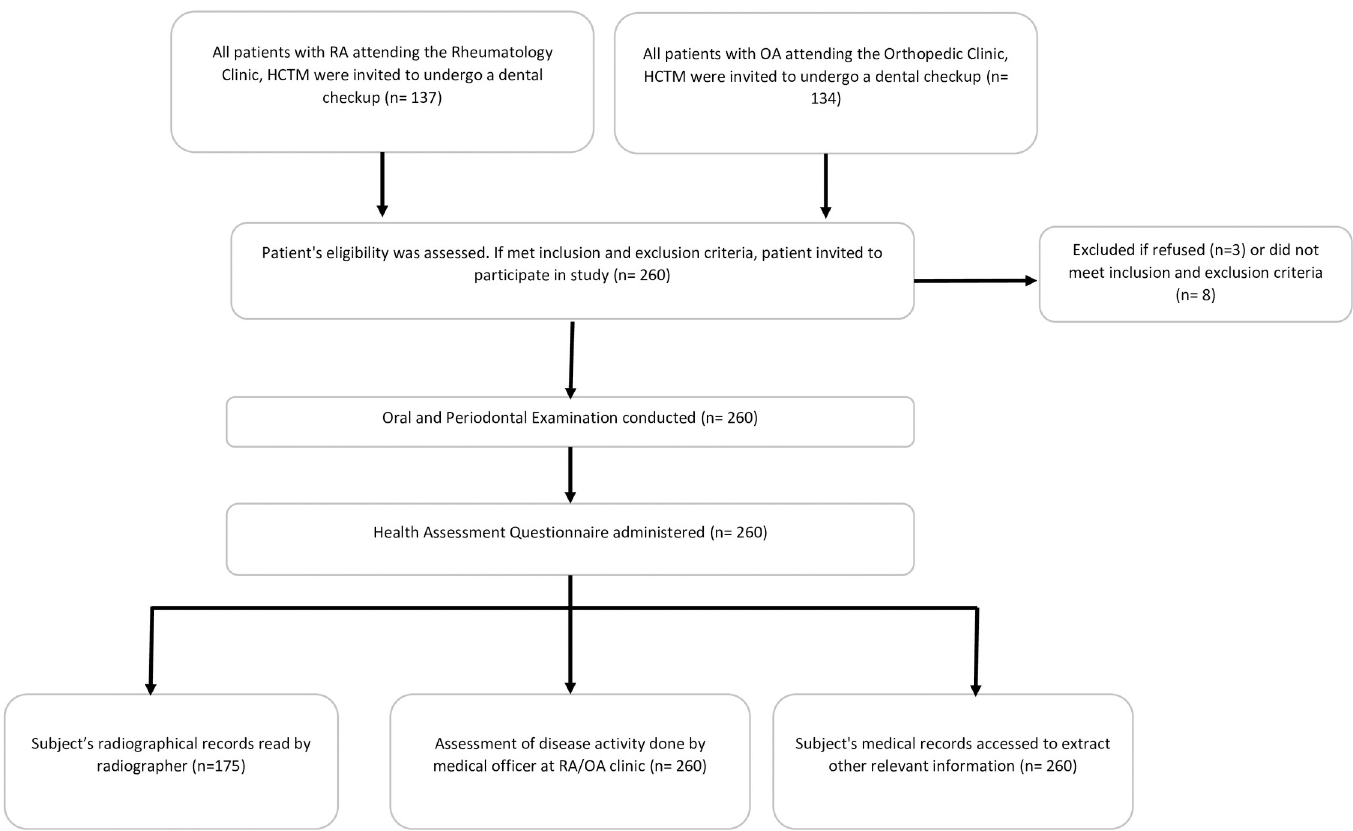
Fig 1. Flow diagram of the recruitment and data collection of the